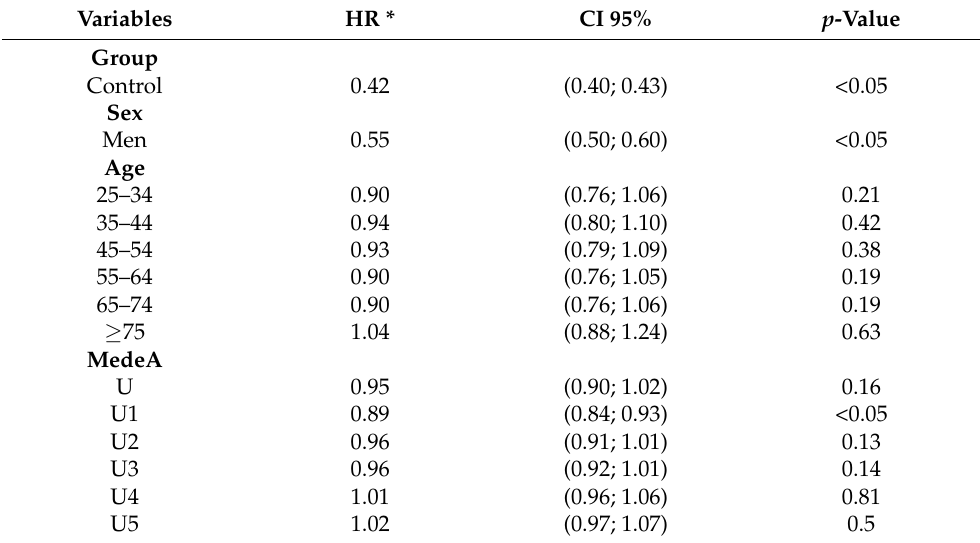
Table 3. Cox model of time to onset of anxiety and/or depression with the variables group, sex, age and